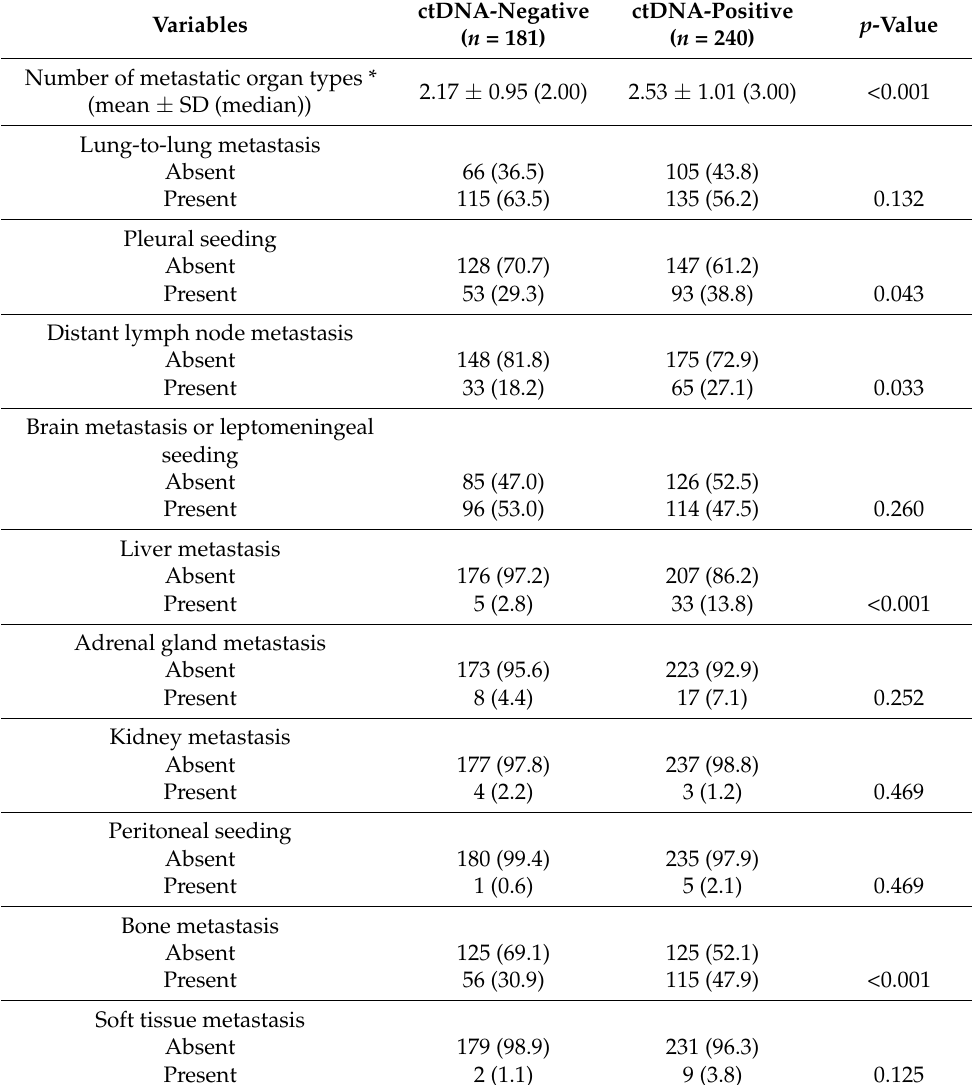
Table 4. Comparison of the type of metastatic organ between ctDNA-positive and